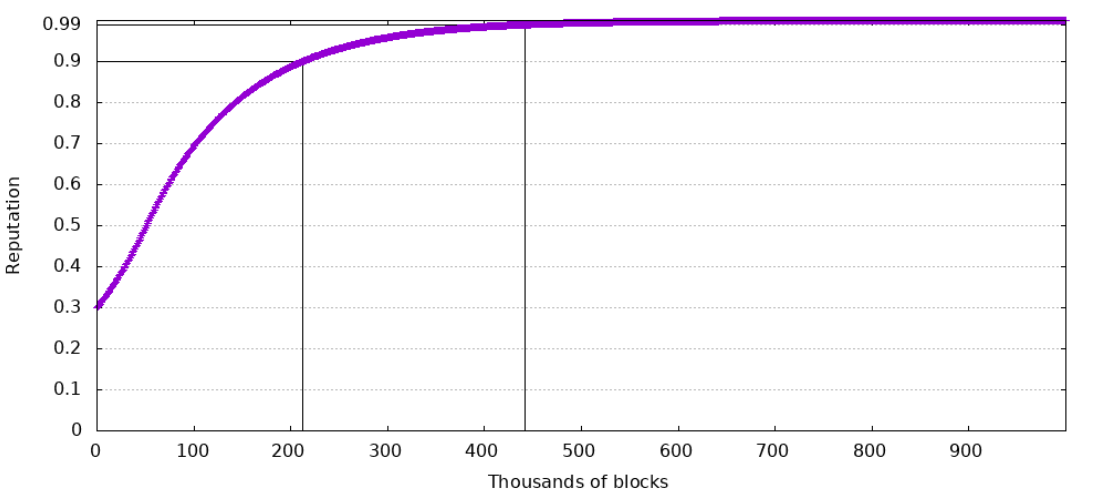
Figure 9. Reputation change over time (speedCoefficient = 5 × 10 − 5